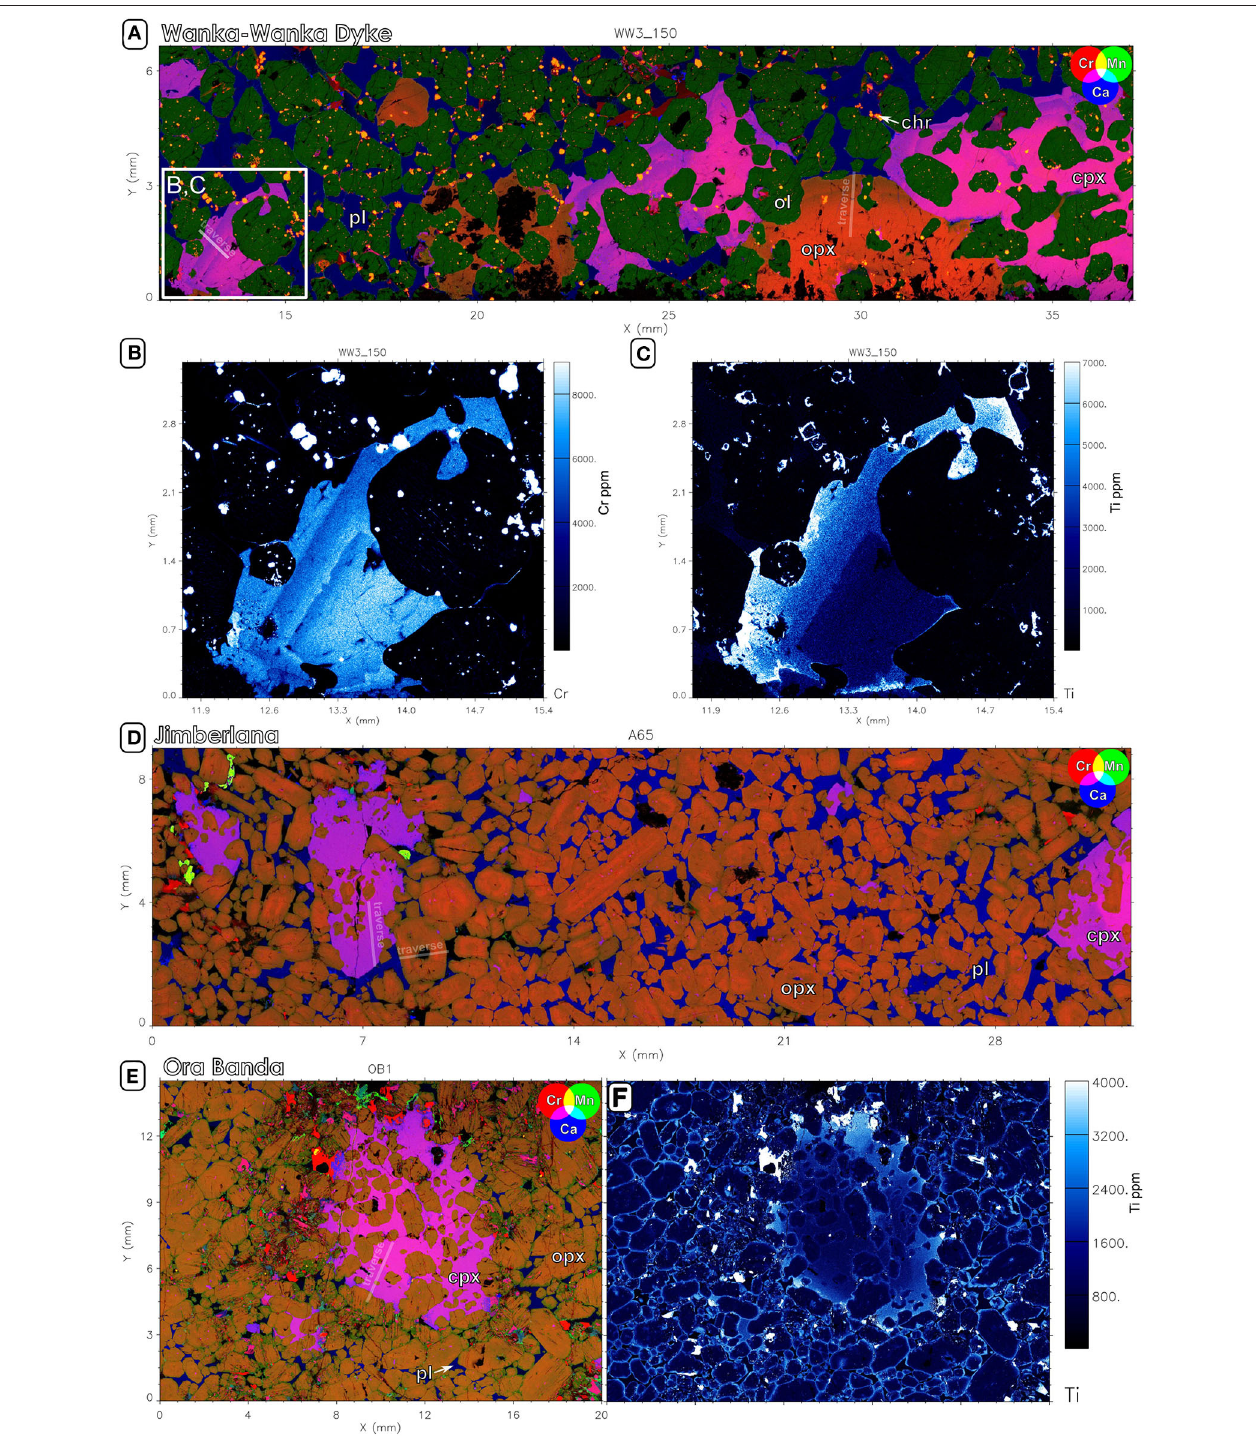
FIGURE 9 | Pyroxene textures in mafic intrusions that are not associated with mineralization (other than localized minor disseminations). (A) Wanka Wanka Dyke with inset of (B,C) . (B) Cr map of clinopyroxene; oscillatory zoning. (C) Ti map of clinopyroxene; normal zoning. (D) Jimberlana; large clinopyroxene oikocryst that contains small orthopyroxene chadacrysts in a matrix of weakly sector zoned orthopyroxene and plagioclase. (E) Ora Banda; large clinopyroxene oikocrysts with orthopyroxene chadacrysts in an orthopyroxene and plagioclase matrix. (F) Normal zonation in Ora Banda pyroxene with an increased in incompatible elements (such as Ti) in the rims. X-ray Fluorescence (XRF) images collected from the Australian Synchrotron using low energy (7,050eV) method (Barnes et al., 2020) Stacked false color (RGB) image of chromium concentration in red, manganese in green and calcium in blue. Mineral abbreviations: cpx, clinopyroxene; ol, olivine; opx, orthopyroxene; pl,